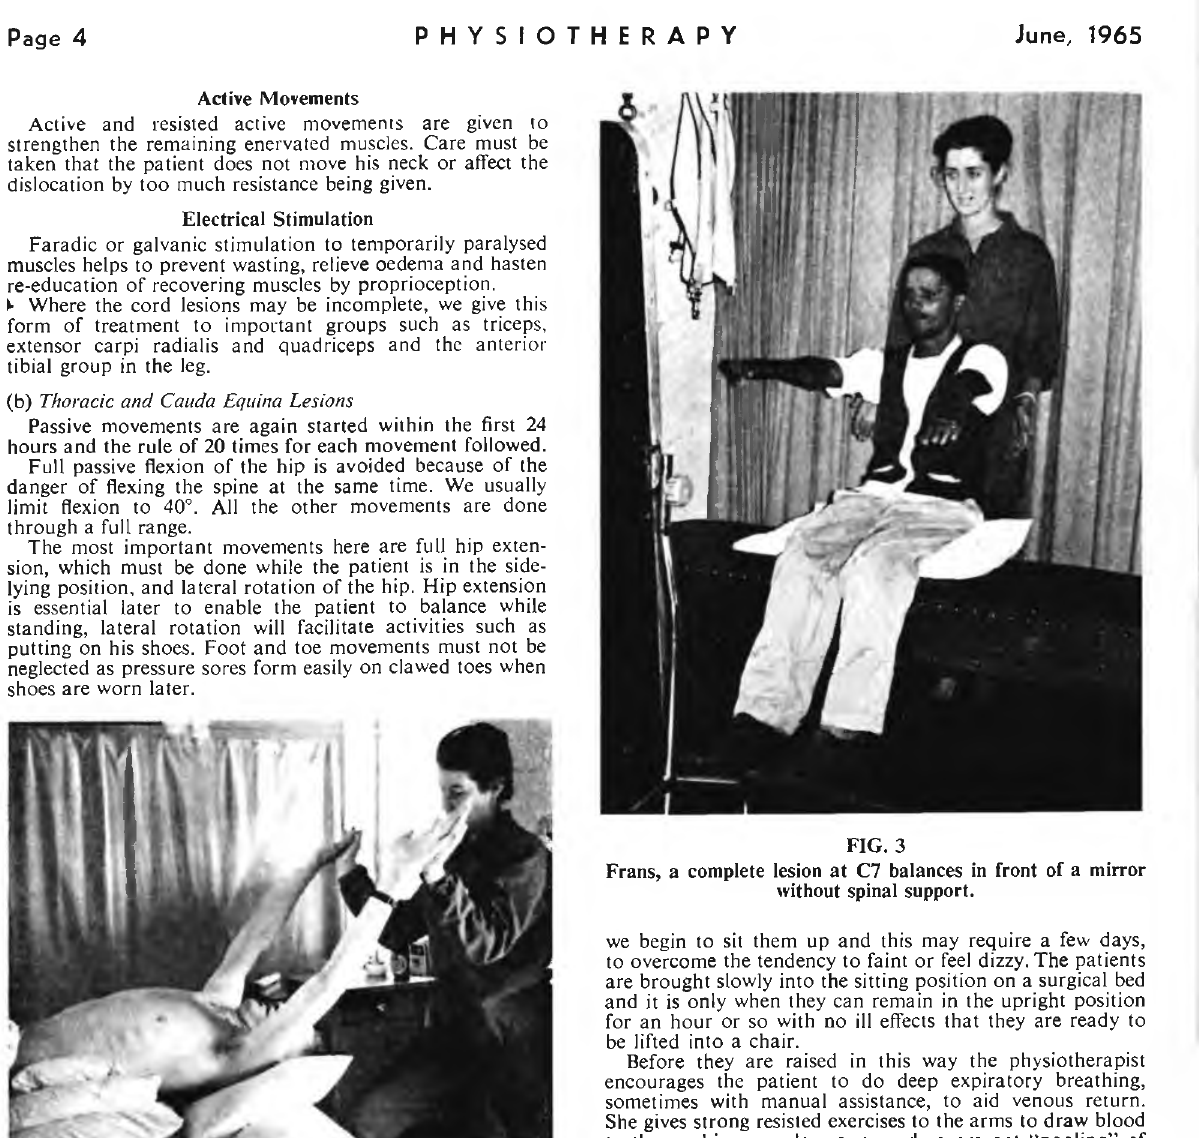
FIG. 2 A patient with a recent fracture dislocation of T il on T12, while being nursed in hyper-extension does manually resisted